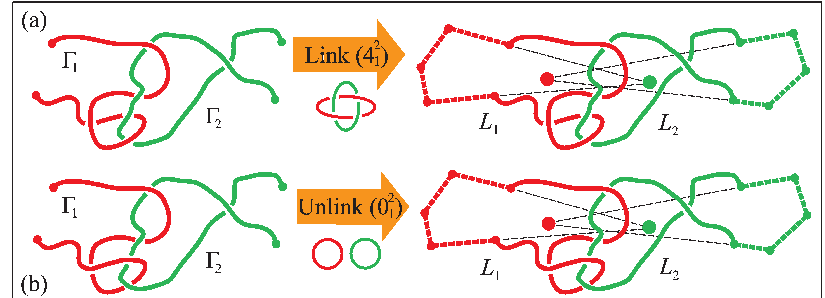
Figure 1. Detection of physical links: The sketches illustrate a key step of the procedure, namely how a pair of open chains can be turned into rings by closing each of them with an auxiliary arc (thick dashed lines) pointing away from the centre of mass of the partner chain (filled circles). To minimize the additional entanglement that may arise during closure, the segments pointing away from the centre of mass of the other chain are typically chosen to be much longer than the radius of gyration of the chains. This closure “at infinity” turnes the two chains, Γ 1 and Γ 2 , into the components, L 1 and L 2 , of a proper link, whose topology can be established with suitable invariants, such as the multivariate Alexander polynomial. The procedure correctly distinguishes between the non-trivial entanglement in panel (a), a Solomon physical link, from the unlink of panel (b). The 2 and 0 2 in the Rolfsen’s notation 16 two link types are indicated, respectively, as 4 1 1